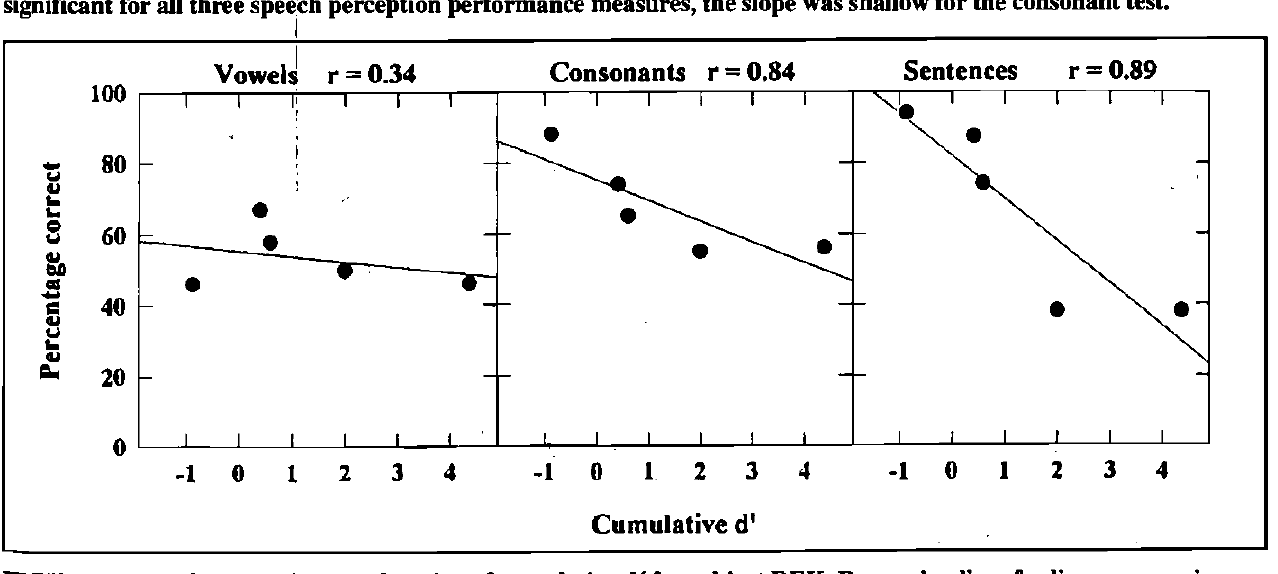
FIGURE 6. Speech perception as a function of cumulative d' for subject REK. Regression lines for linear regression are fitted through the data. The correlation coefficients are shown above each panel. This subject demonstrated a decline in performance levels for increasing cumulative